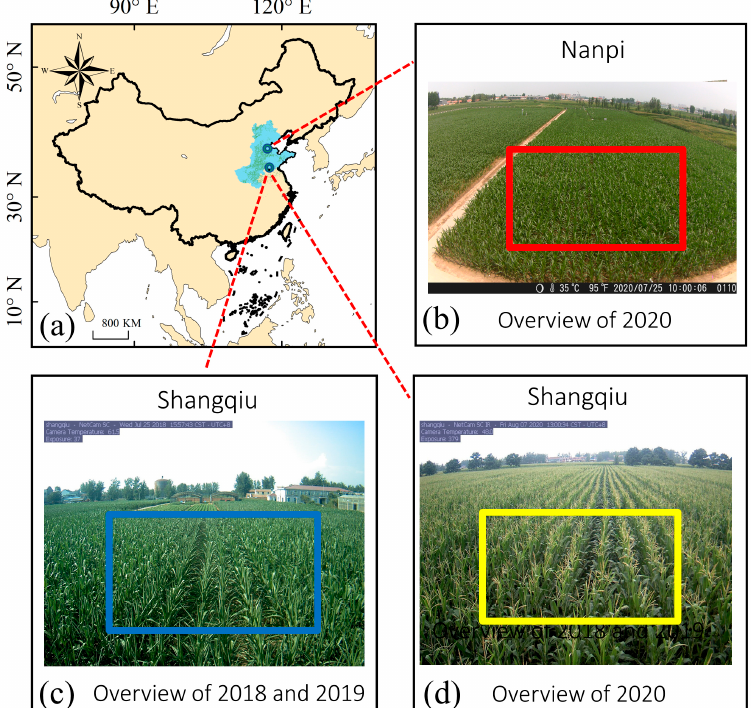
Figure 1. The geographic location of the experimental site and the region of interest (ROI) selection for data analysis. ( a ) Geographic location of the experimental sites; light-blue shaded area represents the North China Plain (NCP). ( b ) View of the phenocam for Nanpi in 2020. ( c , d ) View of the phenocam for Shangqiu in 2018 and 2019, and 2020, respectively. Note: the red, blue and yellow boxes in ( b – d ) indicate the ROI for the calculation of the indices.